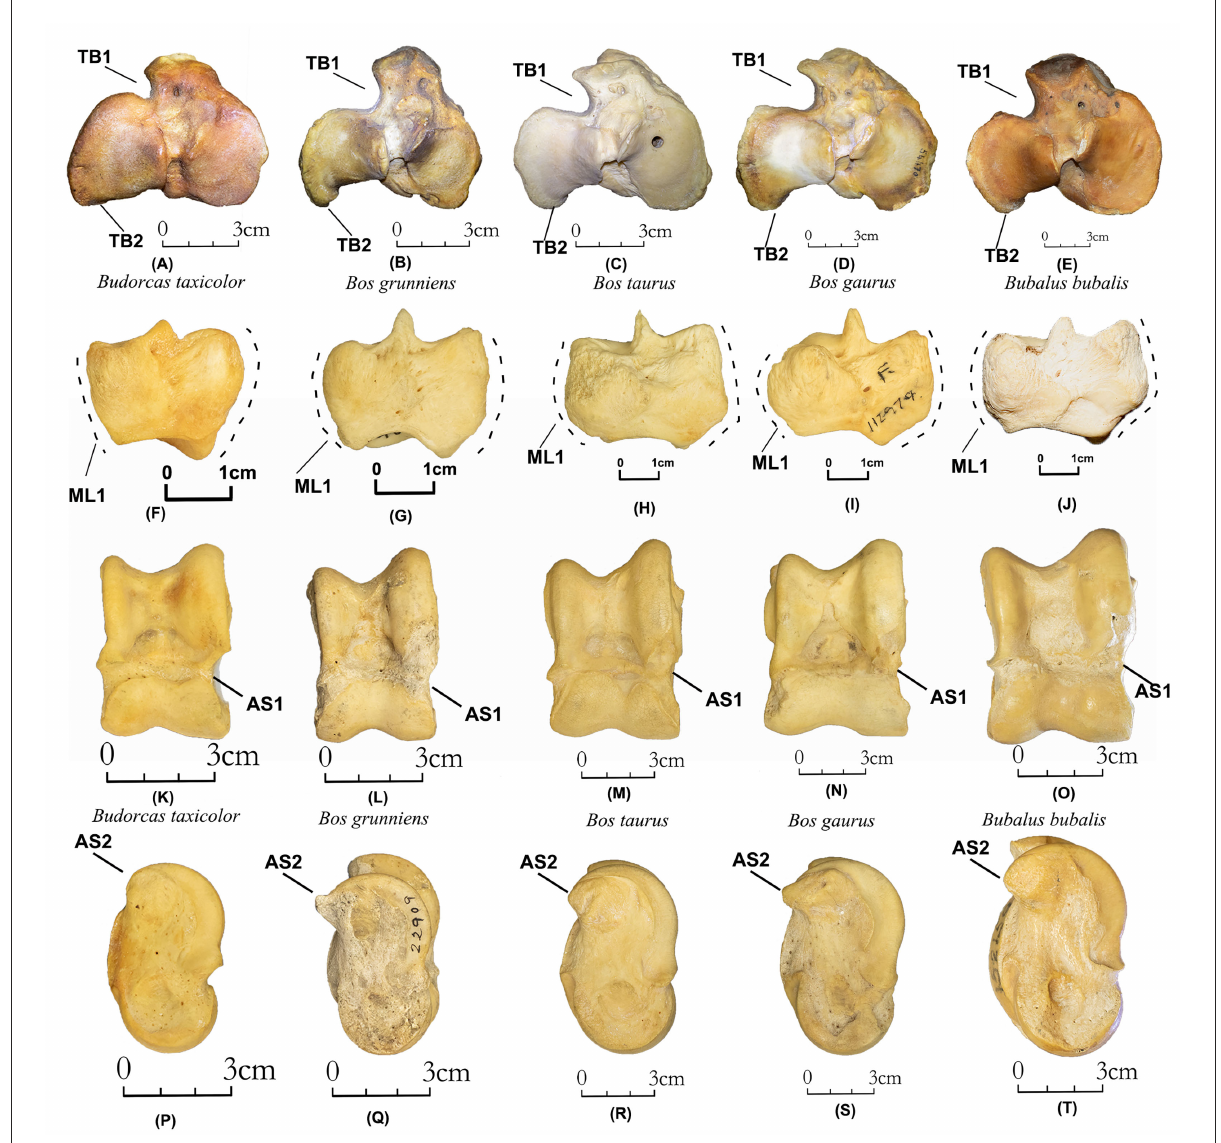
FIGURE7 Tibia, malleolus lateralis, and astragalus of takins and Bovini. Proximal view of the tibia: (A) Budorcas taxicolor (AMNH − 57016), (B) Bos grunniens (AMNH–M − 22909). (C) Bos taurus (AMNH–M − 77932). (D) Bos gaurus (AMNH–M − 54470). (E) Bubalus bubalis (AMNH–M − 54766). Lateral view of malleolus lateralis: (F) Budorcas taxicolor (AMNH − 57016), (G) Bos grunniens (AMNH–M − 90186). (H) Bos taurus (AMNH − 245658). (I) Bos gaurus (AMNH–M − 112979). (J) Bubalus bubalis (Henan − 77). Dorsal view of astragalus: (K) Budorcas taxicolor (AMNH − 57017), (L)